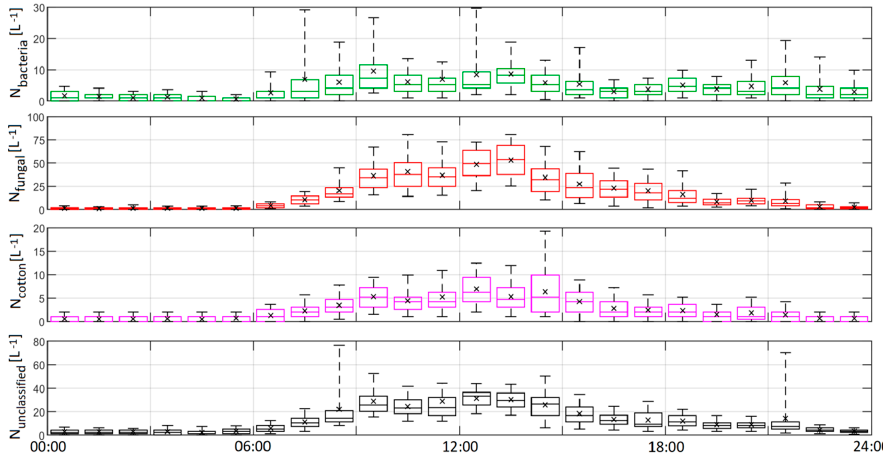
Figure 9. Weekday hourly averaged diurnal number concentrations. Top: Bacteria-like; 2nd row: fungal-like; 3rd row: cotton-like; bottom: unclassified. Whiskers denote 5th and 95th percentiles. Cross denotes mean value.